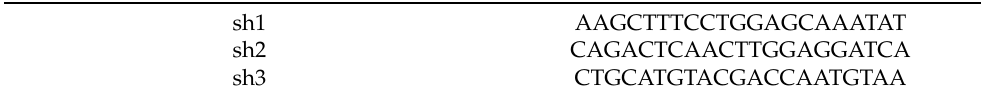
Table 1. shRNA sequences targeting the